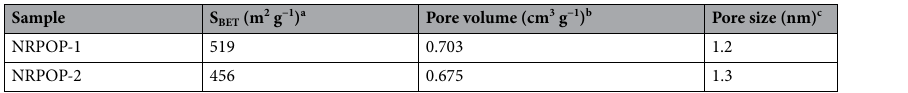
Table 1. Textural properties of NRPOP-1 and NRPOP-2. a BET surface area. b Total pore volume at P / P o = 0.95. c Dominant pore size distribution calculated by NLDFT.